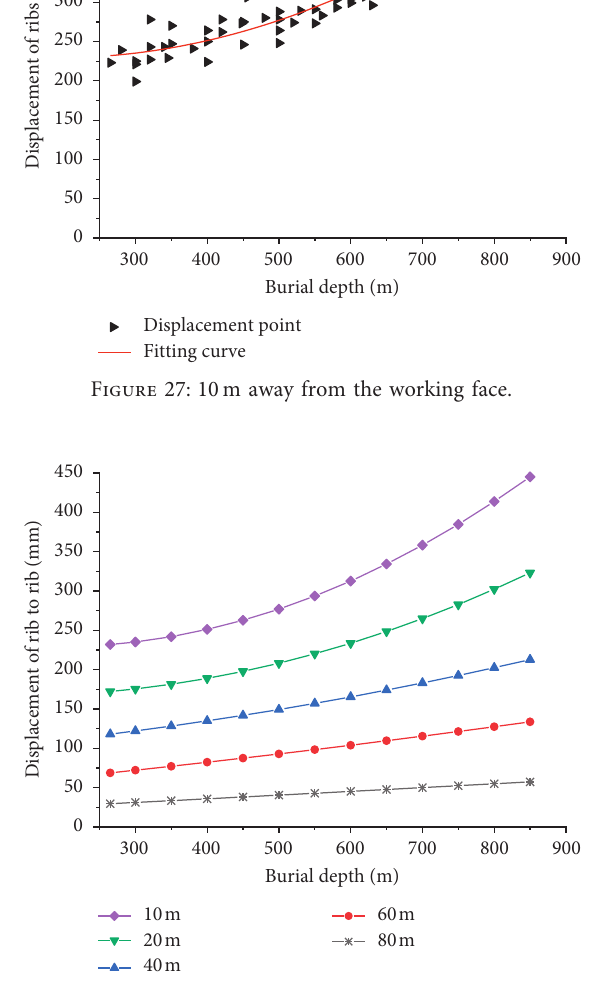
Figure 28: Comparison of displacement of